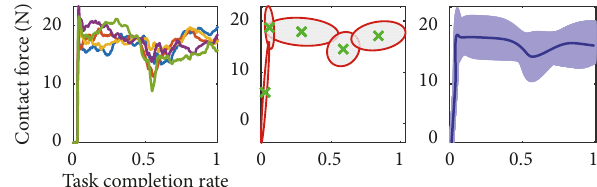
Figure 11: The snapshots for polishing execution with 10s interval.